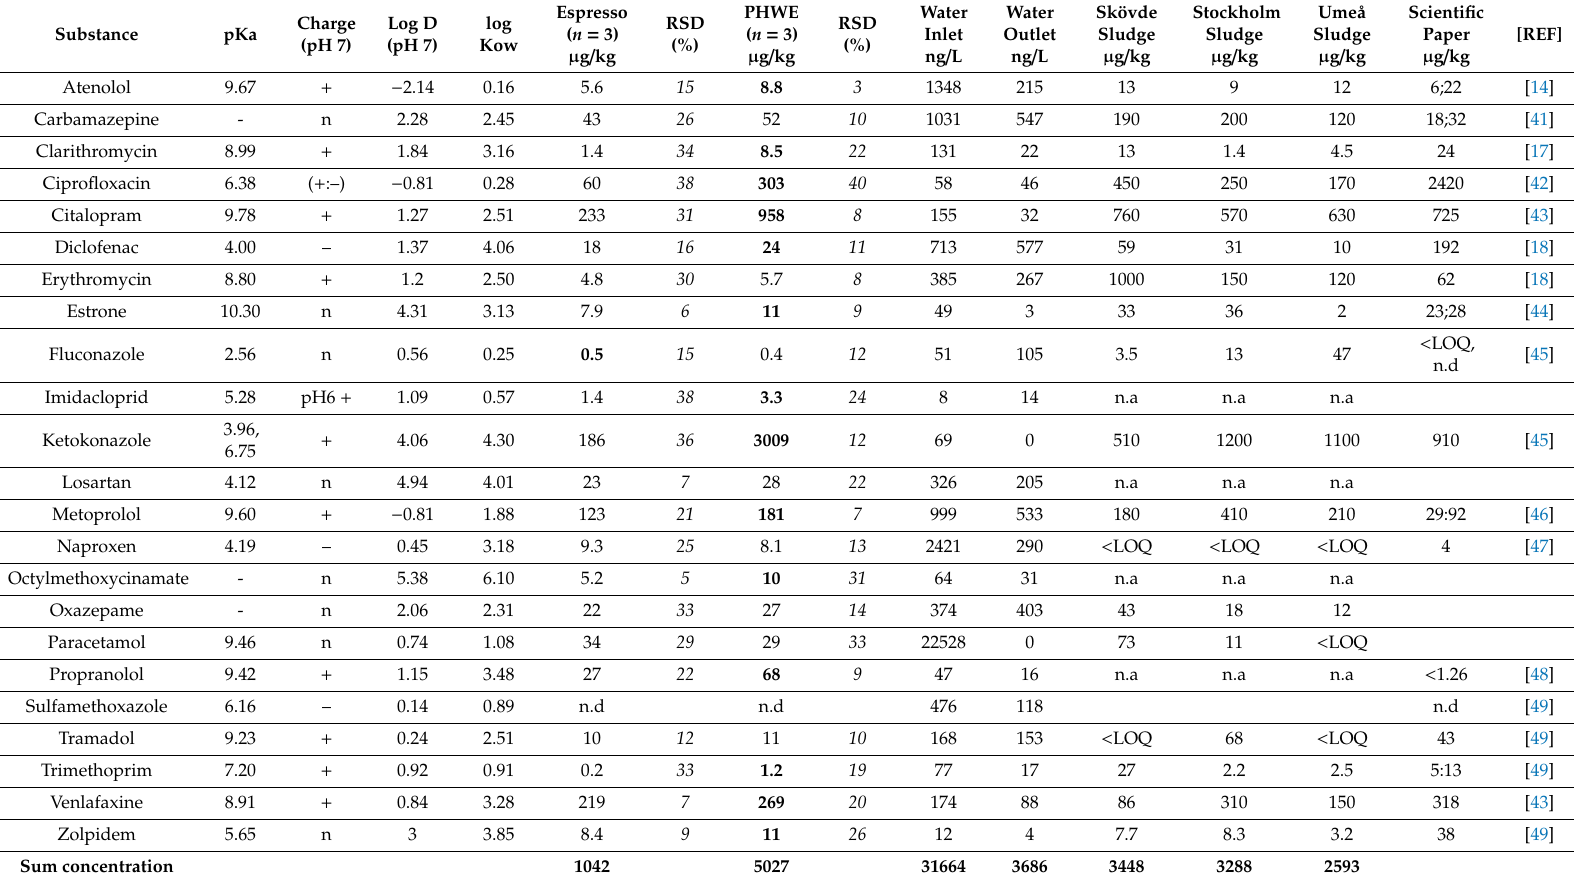
Table 2. Physicochemical properties, and determined concentrations in µ g / kg of 23 APIs in lyophilized sewage sludge from Kristianstad STP using an Espresso method and a PHWE method (RSD %, n = 3). The methods were compared by ANOVA, and bold figures indicate statistically higher concentrations for that method. Inlet at outlet concentrations of the 23 APIs from Kristianstad STP are shown in the table along with previously determined API concentrations from 3 cities (Skövde, Stockholm and Umeå) in a Swedish National Screening Programme 2010. Literature data from scientific international studies are also presented at the end of the